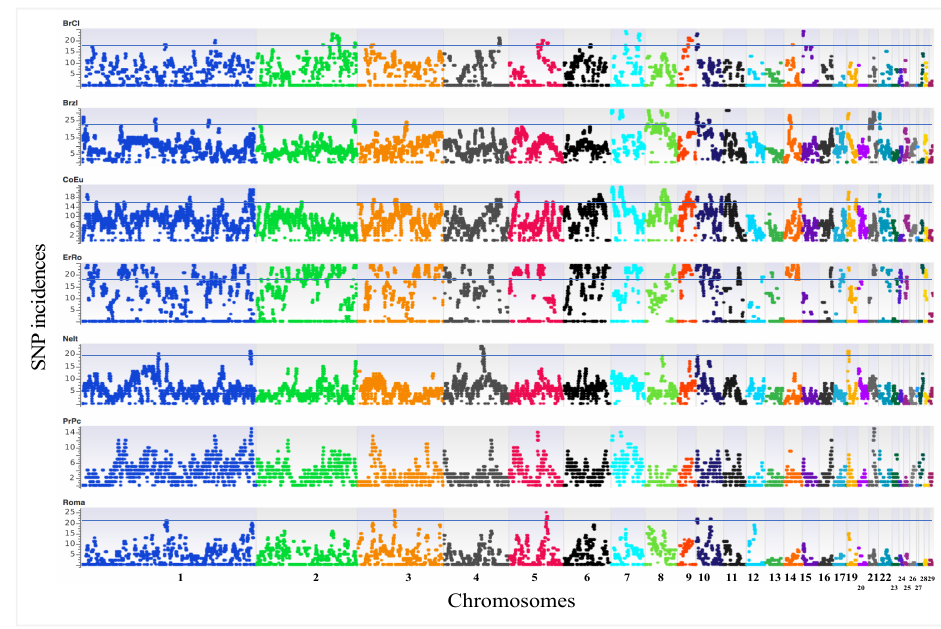
Figure 4. Manhattan plots of SNP incidences for all turkey breeds. A different proportion of proper (identified only in one breed) and common ROH_islands (shared by at least two breeds) were observed among the populations (Figure 5A,B). Two ROH_islands were shared by four breeds (BrCI, Brzl, ErRo, Roma — chr 10; Brzl, CoEu, ErRo, NeIt — chr 19) (Table 3). A total of 25 other ROH_islands were common among breeds with various combinations.